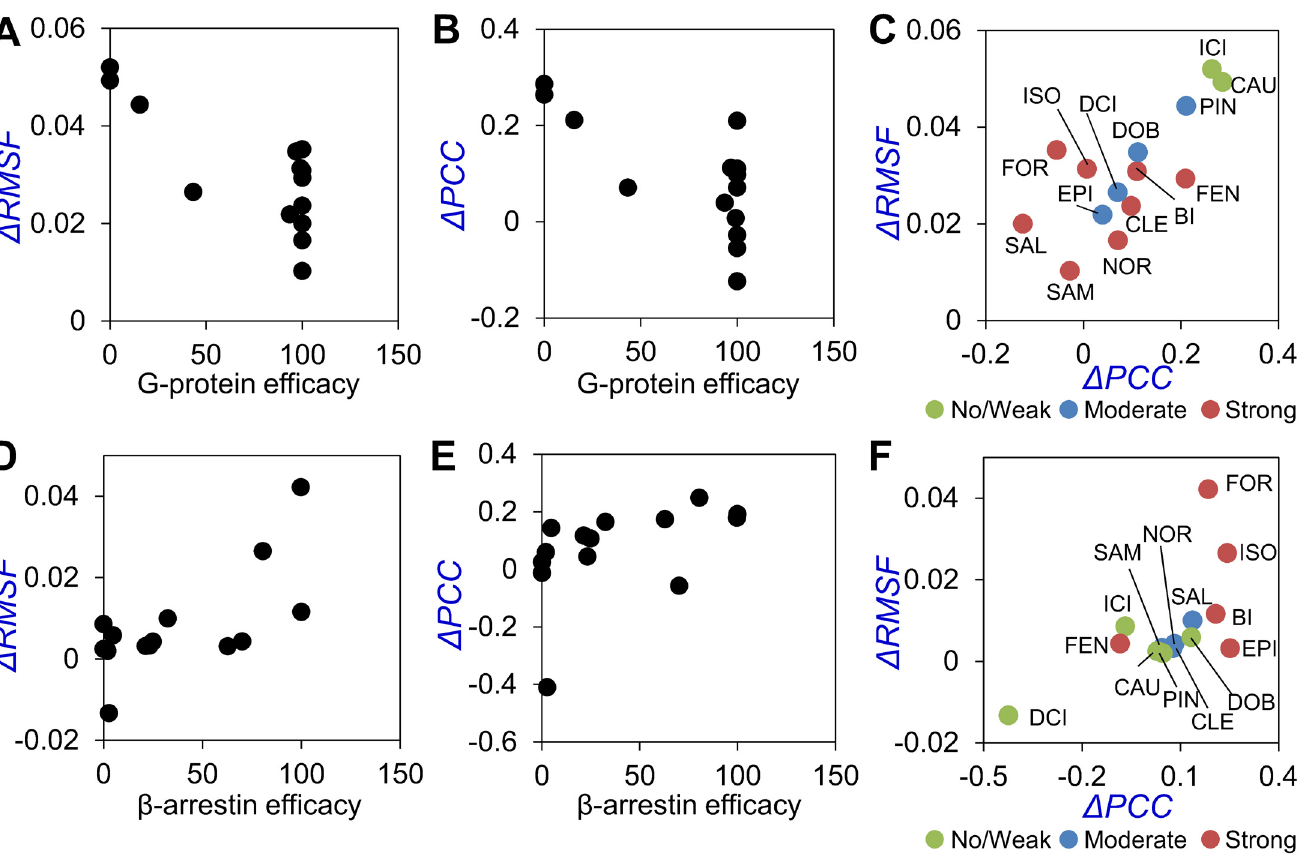
Fig 5. Plots of the mean Δ RMSF and Δ PCC against G protein efficacy. The mean Δ RMSF and Δ PCC using C α atoms, Δ RMSF(C α ) and Δ PCC(C α ), were plotted against G protein efficacy (A, B, C) and β -arrestin efficacy (D, E, F). The 14 ligands are shown as circles. (A) Plot of the mean Δ RMSF(C α ) of helix 6, on which the fluctuating atoms G-protein were particularly concentrated, against the G protein efficacy from a previous study [27]. (B) Plot of the mean Δ PCC(C α ) between helix 3 – helix 6, in which a large number of atom – atom couplings G-protein were detected, against G protein efficacy. (C) Plot of the mean Δ RMSF(C α ) of helix 6 against the mean Δ PCC(C α ) between helix 3 – helix 6. Red: Ligands with a strong G protein efficacy that have larger E max values than isoprenaline; Blue: Ligands with a moderate G protein efficacy that have smaller E max values than isoprenaline; Green: Ligands with no/ weak efficacy. (D) Plot of the mean Δ RMSF(C α ) of specific residues in helix 1 and helix 7 against the β -arrestin efficacy from a previous study [27]. (E) Plot of the mean Δ PCC(C α ) of specific residue pairs between helix 1 and helix 7 against β -arrestin efficacy. (F) Plot of the mean Δ RMSF(C α ) against the mean Δ PCC(C α ). Red: Ligands with a strong β -arrestin efficacy (E max (cid:5) 50); Blue: Ligands with a moderate β -arrestin efficacy (E max 10 – 50); Green: Ligands with no/weak β -arrestin efficacy (E max <